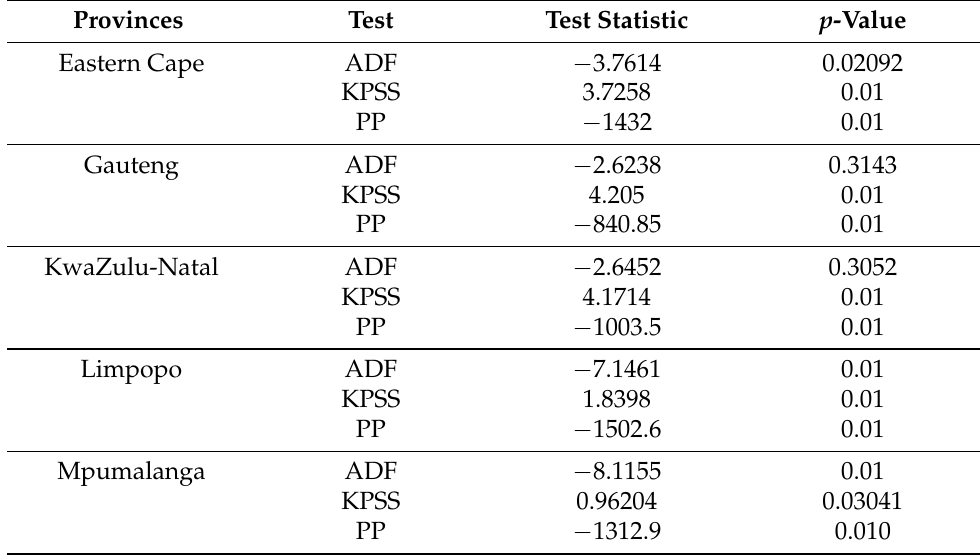
Table 2. ADF, KPSS and PP stationarity test results of monthly rainfall data. Provinces Test Test Statistic p -Value Eastern